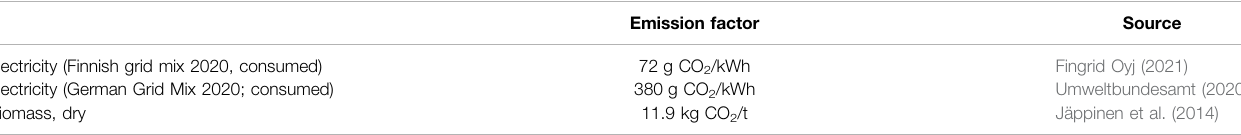
TABLE 1 | Emission factors used in calculation of the CO 2 balance.